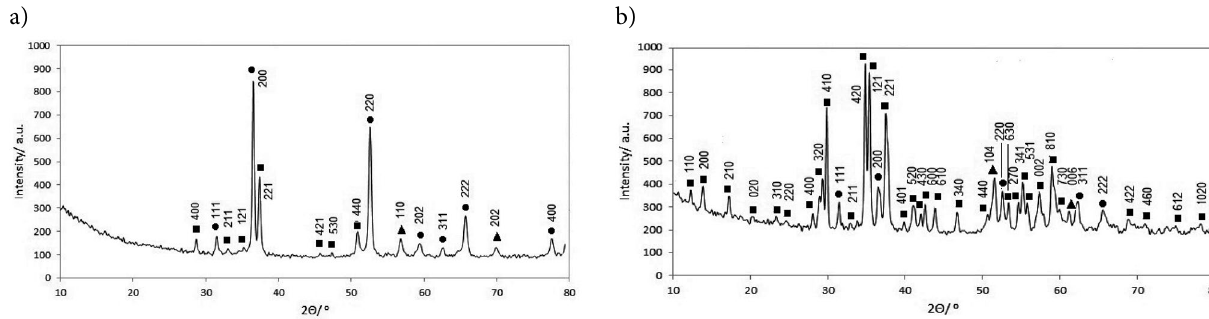
Figure 9. XRD patterns of the alloys of the polythermal section Sn 0.39 As 0.61 –Ge 0.28 As 0.72 : a – 0.10; b – 0.90 mol.f. Ge 0.28 As 0.72 . The symbols denote:  – SnAs;  – GeAs